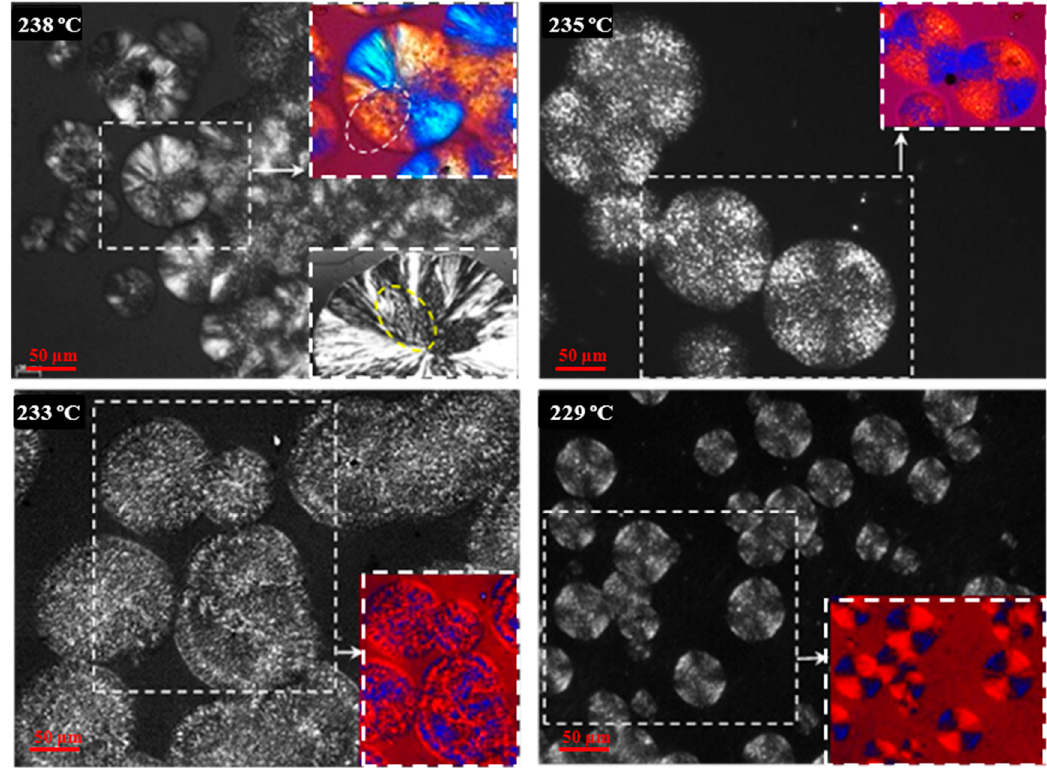
Figure 17. Typical spherulitic morphologies of nylon 4 9 isothermally crystallized at the indicated temperatures. Black and white inset of the micrograph taken at 238 °C reveals the complex internal structure of the obtained spherulites. Color micrographs taken with a red tin plate to determine the sign of birefringence are shown as insets for all crystallizations.